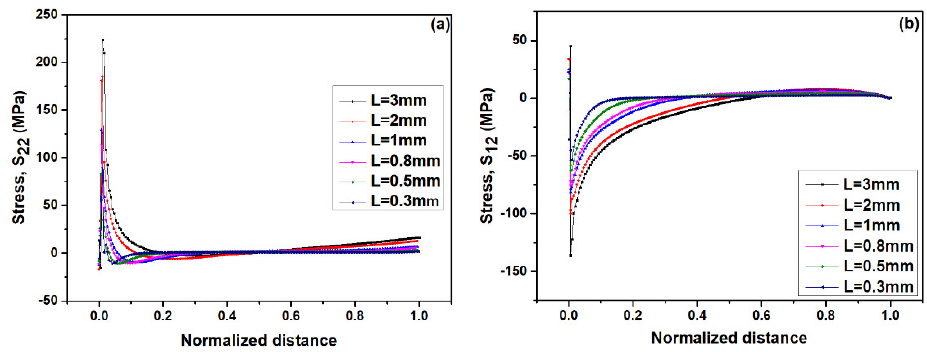
Figure 9. Variation of stresses ( a ) σ 22 and ( b ) σ 12 along crack path at different thickness of TC.